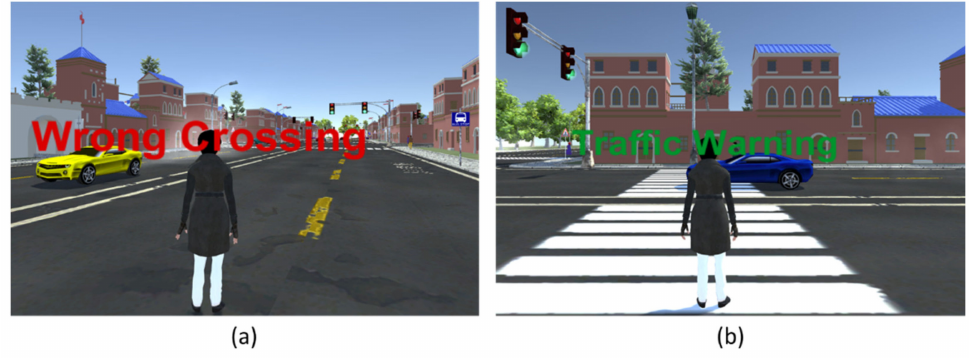
Figure 10. Audible and visible alarm systems where ( a ) shows wrong crossing on the road and ( b ) represents wrong walking on a zebra cross.